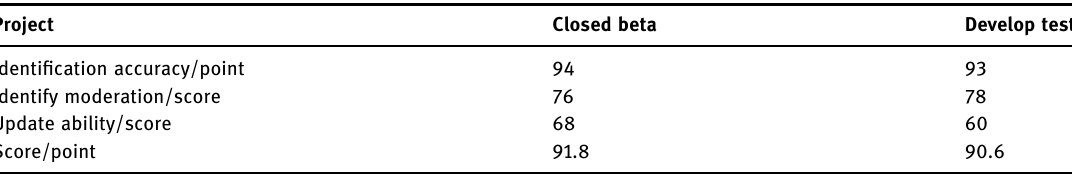
Table 3: Evaluation results of dynamic memory algorithm Project